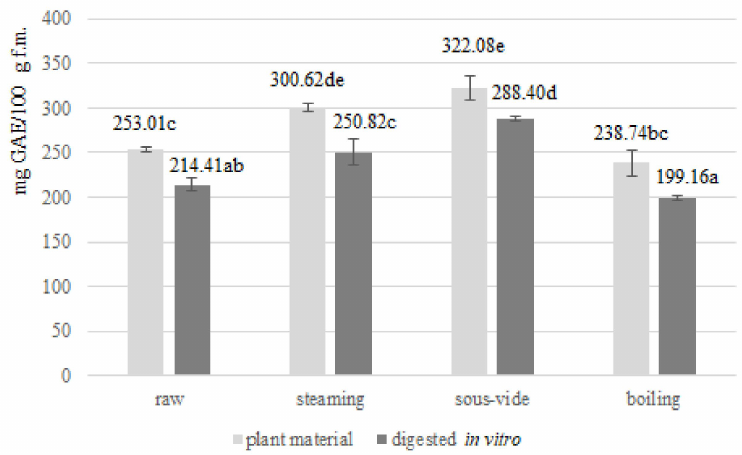
Figure 1. Polyphenols concentration (mg GAE/100 g f.m.) in raw and thermally-treated Brussels sprouts before and after in vitro digestion. Means followed by the same letter (a,b,c,d,e) are not significantly different ( p ≤ 0.05); f.m.—fresh